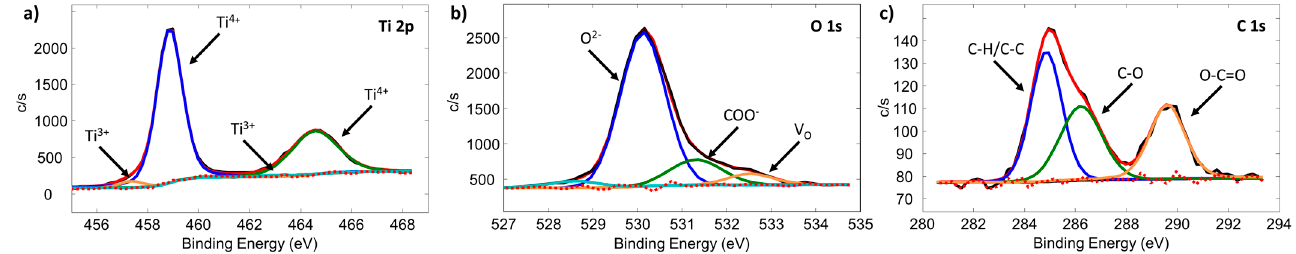
Figure 3. High-resolution XPS spectra of C-TiO 2 photocatalyst layer: ( a ) Ti 2p; ( b ) O 1s; and ( c ) C 1s. Ti 2p 3/2 and Ti 2p 1/2 spin-orbital doublet peaks (at approximately 459 eV and 464.5 eV, respectively) were fitted by two titanium chemical states. The main Ti 2p 3/2 peak at 458.8 eV was ascribed to the TiO 2 phase. Its binding energy is slightly higher than the reference TiO 2 value but is equal to the value observed for the TiO 2 samples with oxygen vacancies [66]. The presence of oxygen vacancies and/or distortion caused by carbon doping is also evident by the observation of a smaller peak at 457.4 eV, which is attributed to the Ti 3+ state [66]. We presume that the contribution of the Ti 3+ state is relatively low (the area ratio of Ti 3+ and Ti 4+ peaks is approximately 3.5:96.5) because the lack of some Ti-O bonds is compensated by partial titanium bonding directly to carbonaceous species. This is supported by O 1s and C 1s spectra (Figure 3b,c, respectively), which indicate, that in addition to peaks ascribed to O 2 − anions in crystalline titanium dioxide (530.1 eV) and graphitic carbon (284.8 eV), there are at least four additional peaks. As discussed by L. Zhang et al. [66] and P. Zabek et al. [67], O